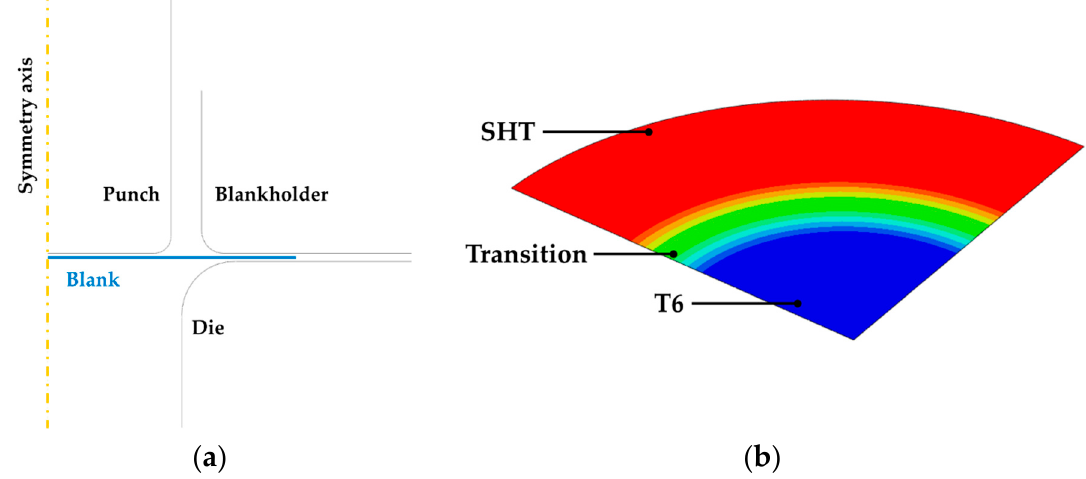
Figure 5. Finite Element (FE) model of the deep drawing process: ( a ) 2D axisymmetric approach, ( b ) distribution of material properties over the LHT blank.